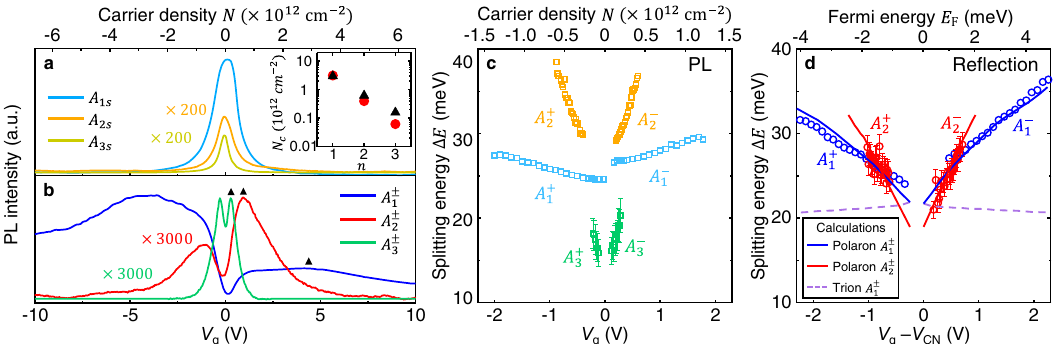
Fig. 4 Gate-dependent optical characteristics of ground and excited exciton polarons in monolayer MoSe 2 . a , b Gate-dependent integrated PL intensity of excitons and exciton polarons, plotted in arbitrary unit (a.u.), as a function of gate voltage (bottom axis) and charge density (top axis). The charge neutrality point is at V g = 0 V. We magnify the A 2 s , A 3 s ( A ± maximum PL intensity in b (black triangles), compared to the quenching charge density (red dots) expected from the state- fi lling effect with the exciton radii in Fig. 1d. c Gate-dependent PL splitting energy between A ± respectively). d Gate-dependent splitting energies between the A ± (red circles). The charge neutrality point is at V CN (cid:3) 0.25 V, which has been subtracted from V g . The purple dashed lines are the calculated trion binding energy. The blue (red) solid lines are the calculated A ± smaller than the symbols) in c ( d ) represent the uncertainty in fi tting the PL (re fl ection) features.